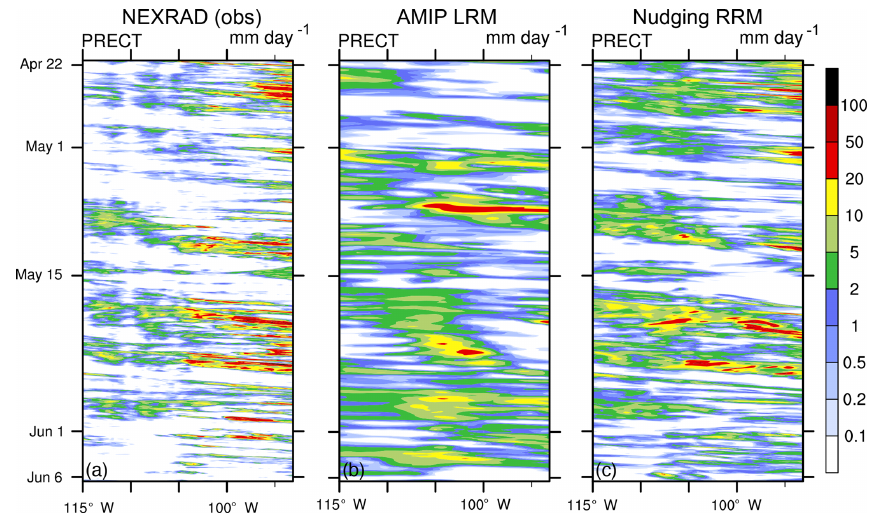
Figure 18. Hovmöller plots of hourly mean total precipitation (unit: mmd − 1 ) over 35–45 ◦ N, 93–115 ◦ W during 22 April–6 June 2011 for (a) NEXRAD observations, (b) AMIP LRM, and (c) nudging